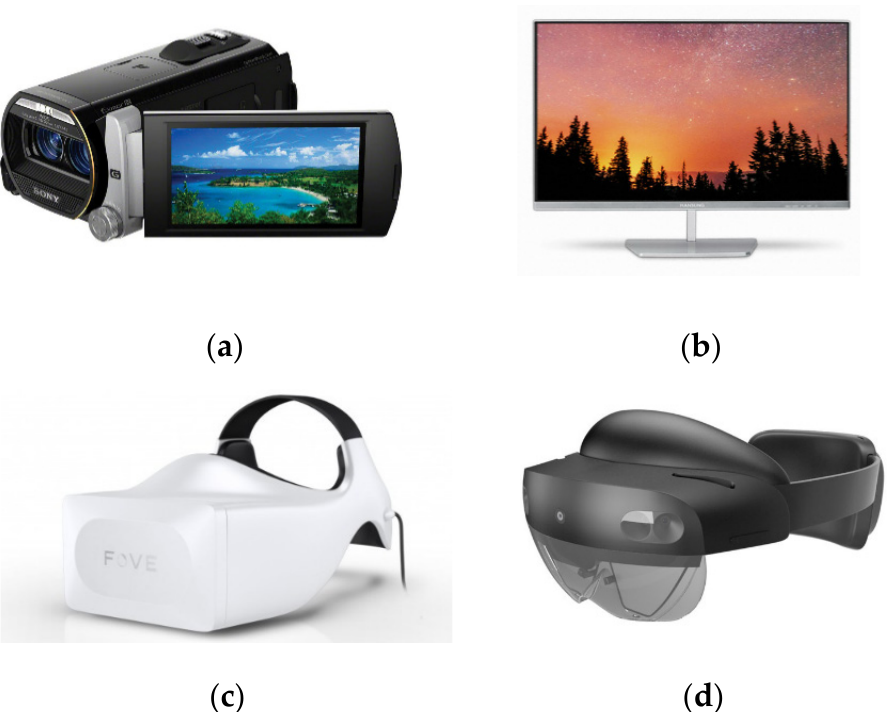
Figure 5. The equipment used in each environment to measure the blink rate: ( a ) TD20 camera; ( b ) Ultron 2457 monitor; ( c ) FOVE HMD; and ( d ) Hololens 2.